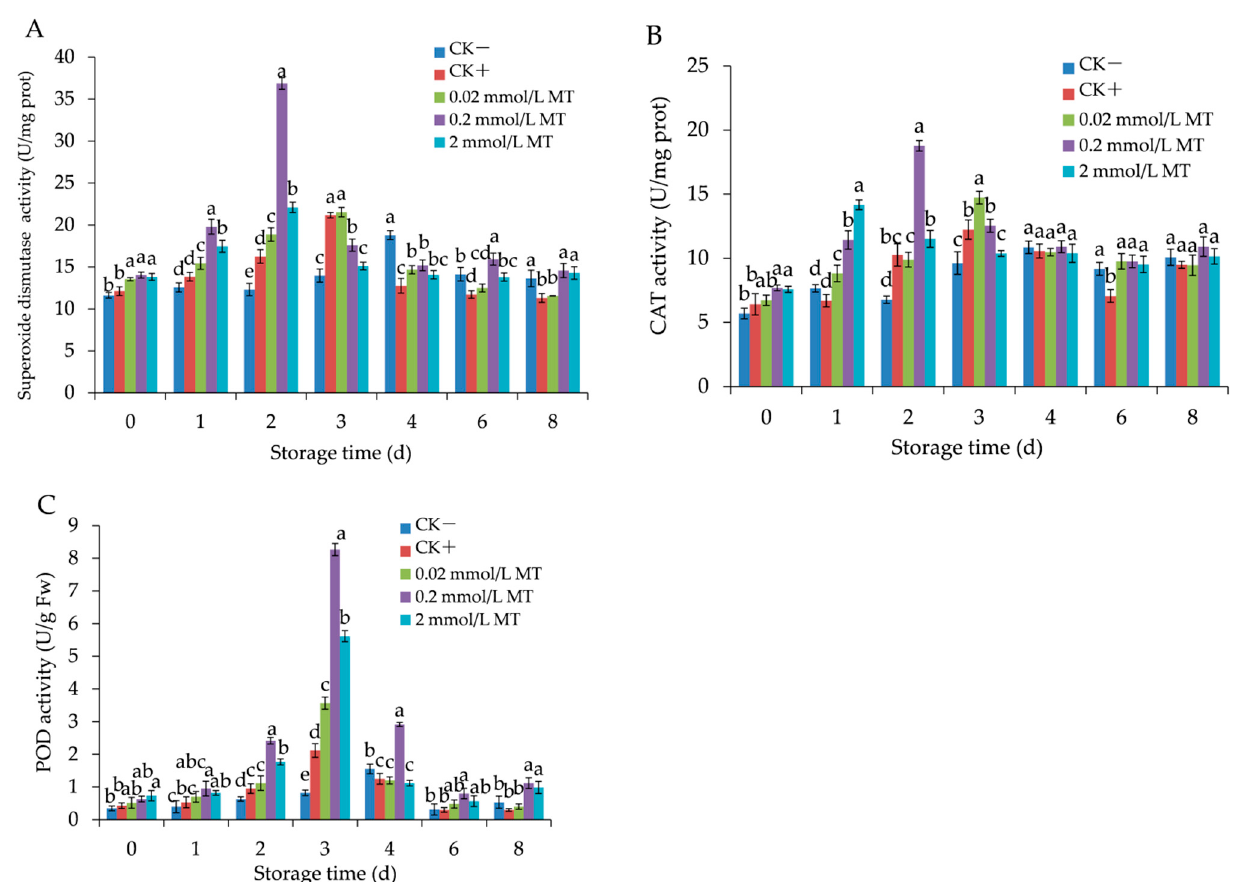
Figure 6. Effect of melatonin treatment on the activities of superoxide dismutase ( A ), catalase ( B ), and peroxidase ( C ) in grape berries. Data represent means ± S.E. ( n = 3). Duncan’s multiple range test was used to analyse significant differences in data, and letters above the bars represent differences at p < 0.05.